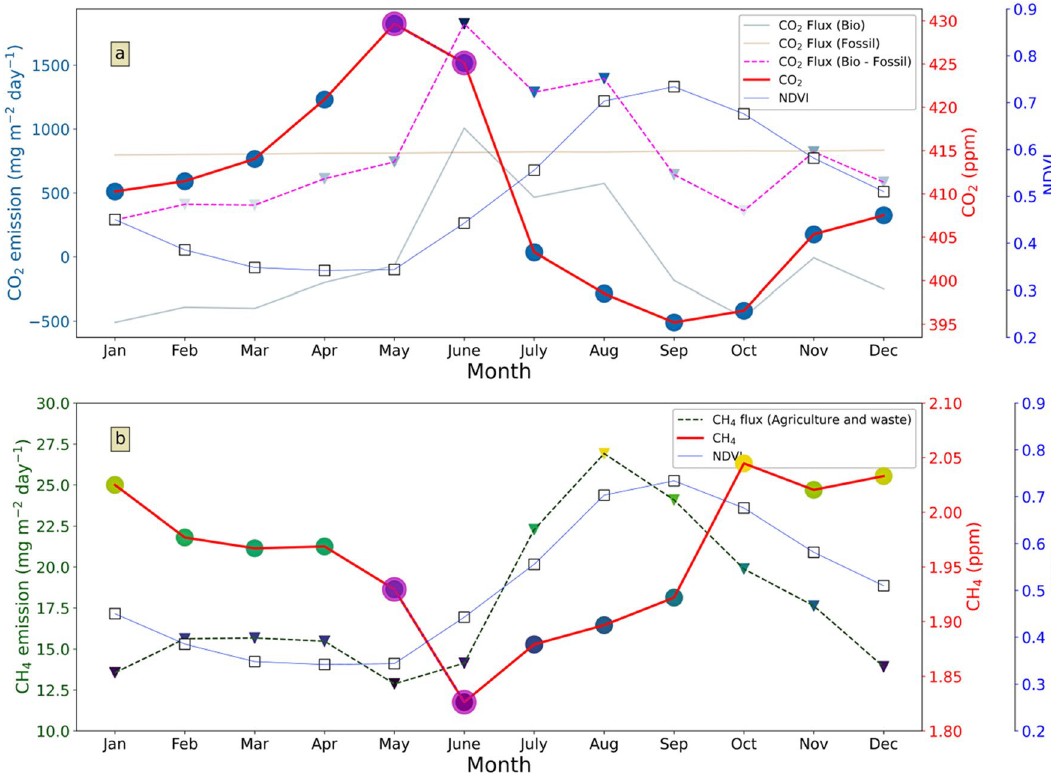
Figure 4. ( a ) Co-variance of CO 2 and NDVI calculated over an area of 0.5° × 0.5° for the entire observation period. ( b ) Co-variation of CH 4 , NDVI, and CH 4 flux from agriculture and waste of CT-product. N.B- The highlighted points in CO 2 and CH 4 time series denotes data from weekly flask